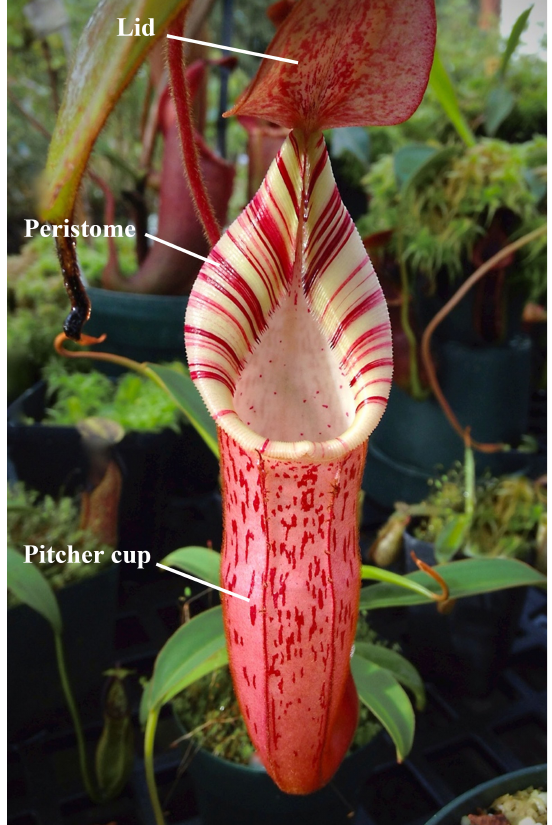
Figure 9. Nepenthes carnivorous pitcher. Adapted from website